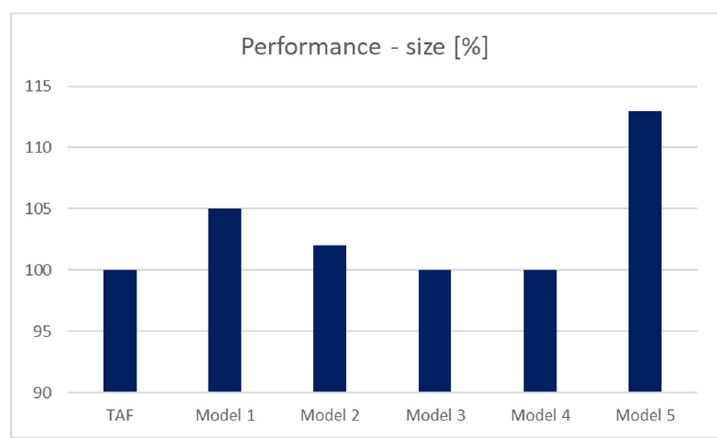
Figure 9. Performance results – processing time (%).